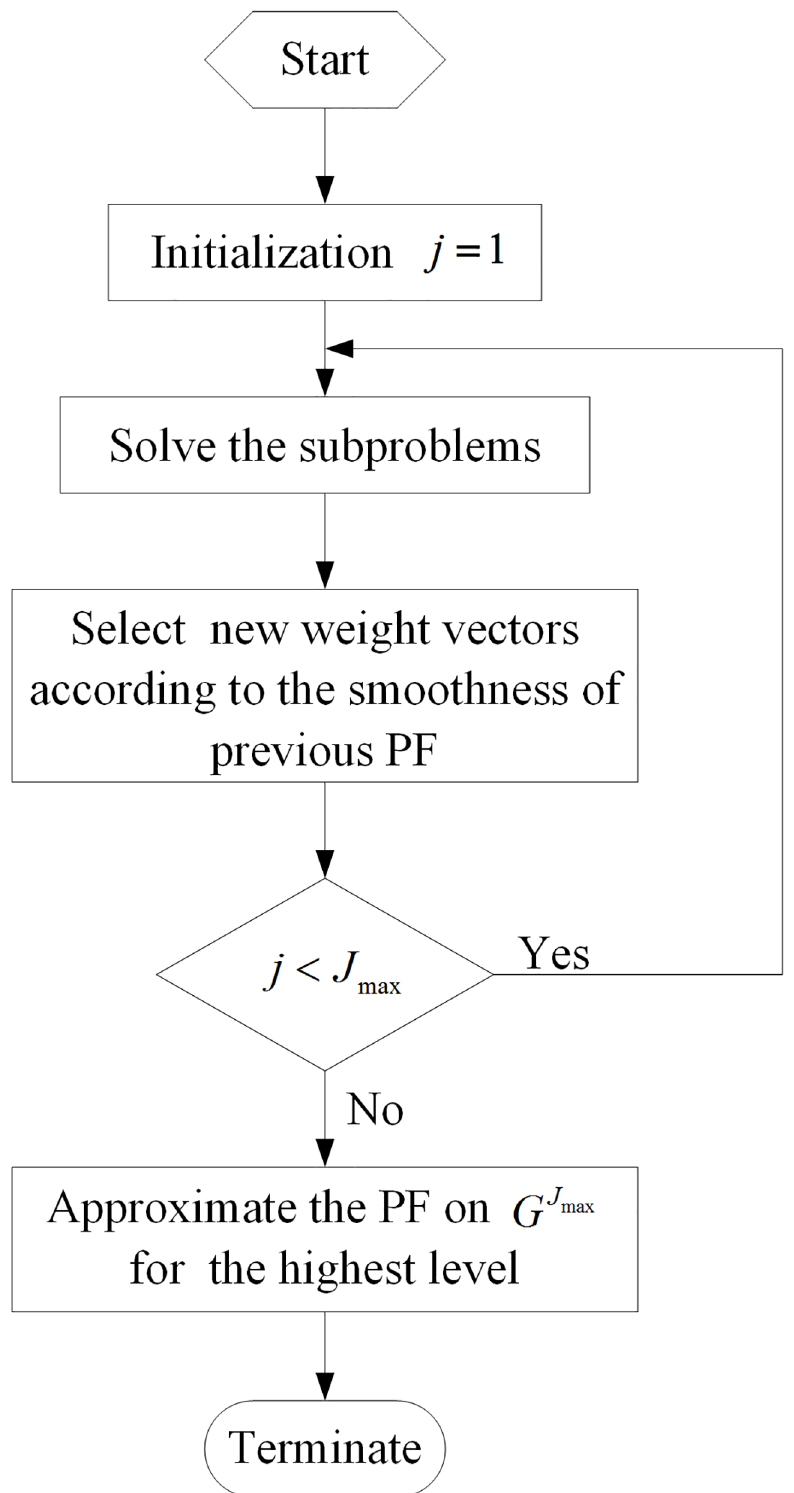
Fig 3. Flowchart of the sequential